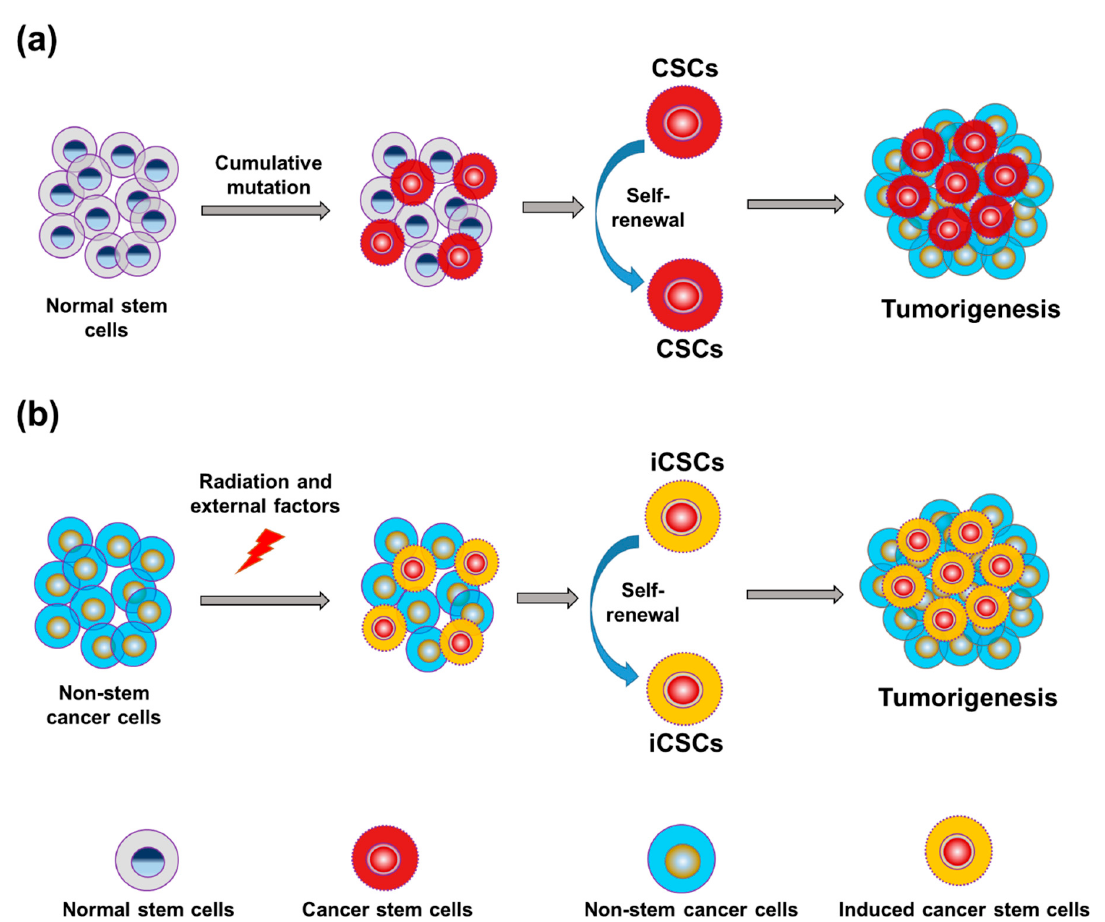
Figure 3. Progression of tumors from normal stem cells and non-stem cancer cells. ( a ) Di ff erentiation of cancer stem cells (CSCs) within the pool of stem cells is a major source of tumorigenesis. ( b ) Radiation and other external factors can form induced cancer stem cells (iCSCs) in the pool of non-stem cancer cells, resulting in